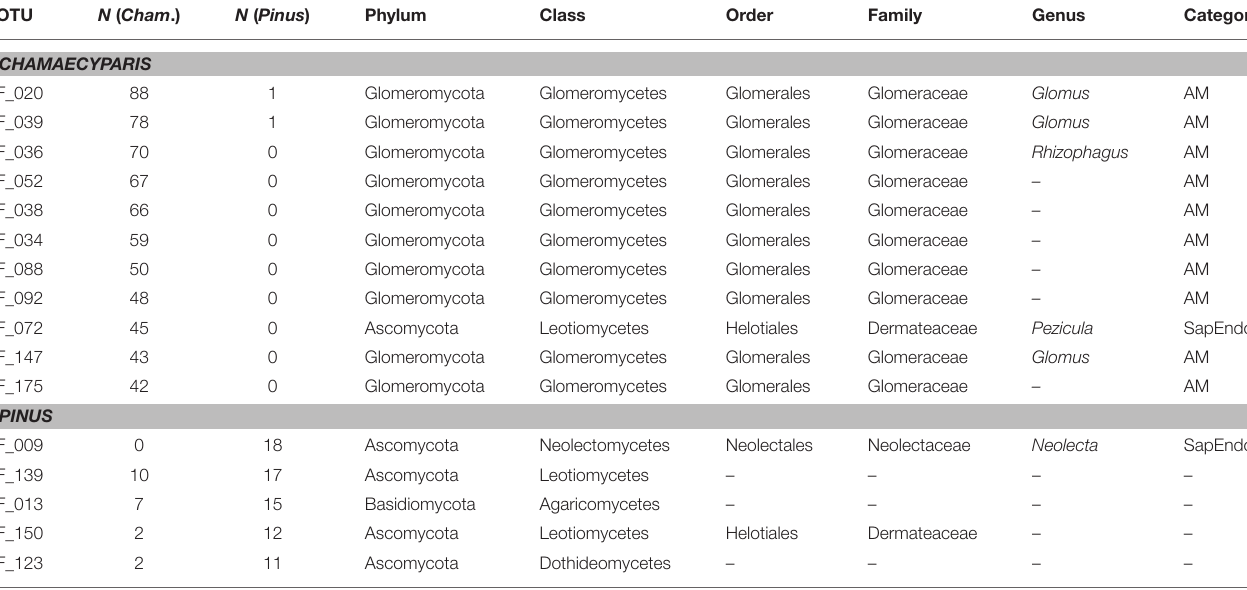
TABLE 2 | Fungal OTUs showing statistically significant host preferences. OTU N ( Cham